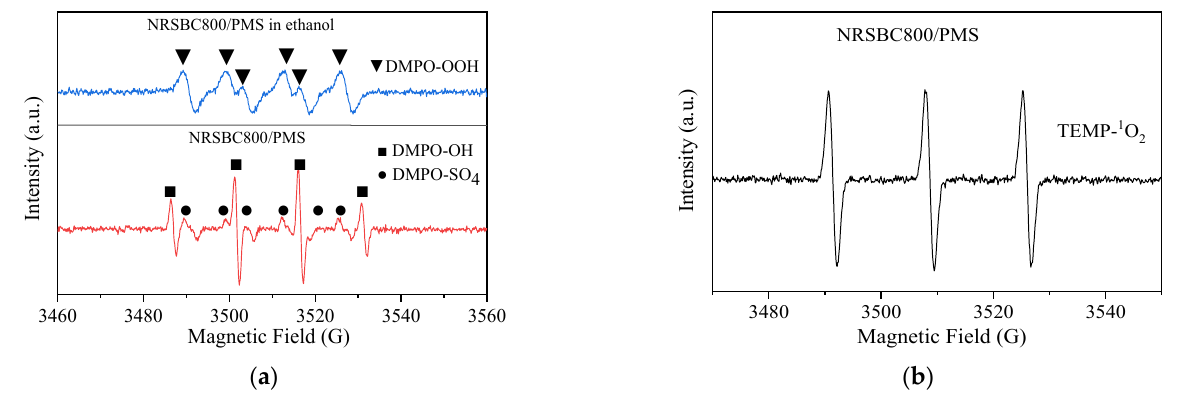
Figure 5. EPR spectra of DMPO-OOH, DMPO-OH and DMPO-SO 4 ( a ) and the TEMP- 1 O 2 adduct ( b ) formed in the NRSBC800/PMS system. ( a ) Initial reaction time and ( b ) 5 min after PMS activation. Condition: [NRSBC800] = 100 mg/L, [PMS] = 614 mg/L, T = 25 °C, [DMPO] = 20 mM and [TEMP] = 100 mM.